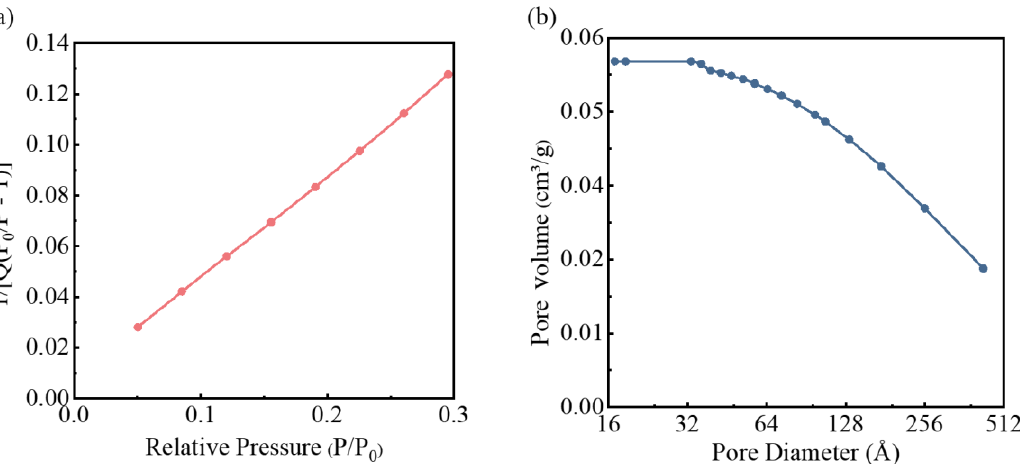
Figure 4. SEM microscopy of oily sludge.